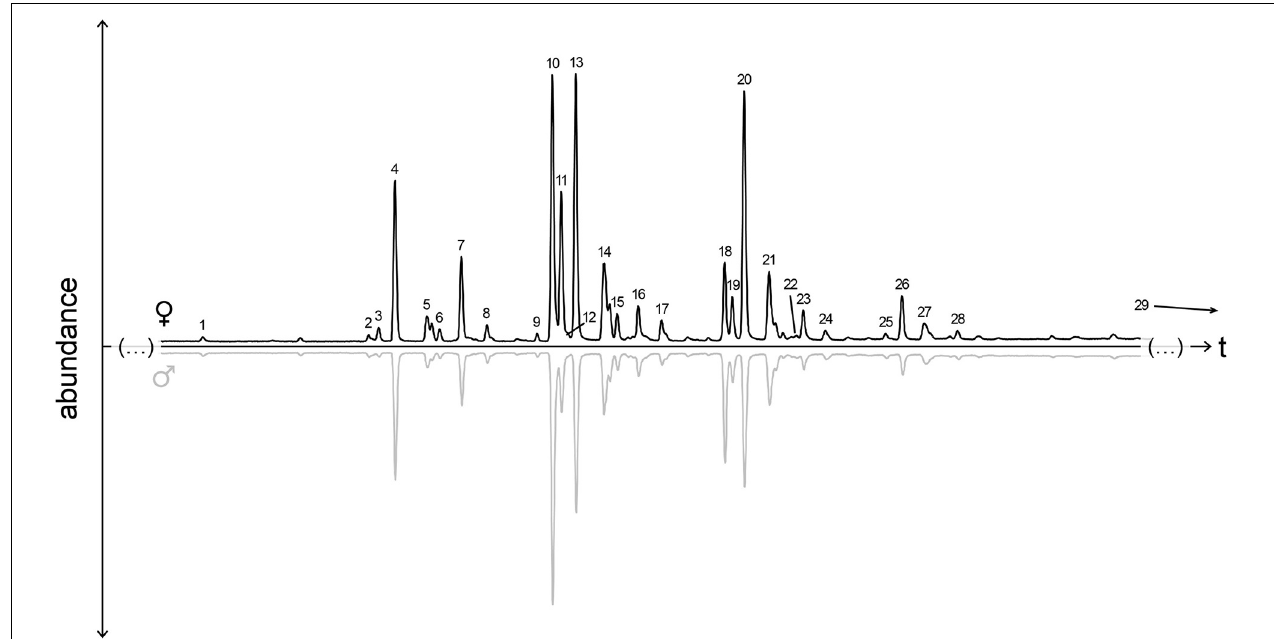
FIGURE 1 | Composition of cuticular hydrocarbon profiles of female and male Tachinaephagus zealandicus . Representative chromatograms of extracts from a female (top) and a male (bottom), scaled relative to the amount of internal standard (1-octadecene, 6.25 ng, not shown; elutes before peak 1). Peak numbers correspond to the compounds listed in Table 1 . Peak 29 (11-methylheptatriacontane) not shown, elutes much later than peak